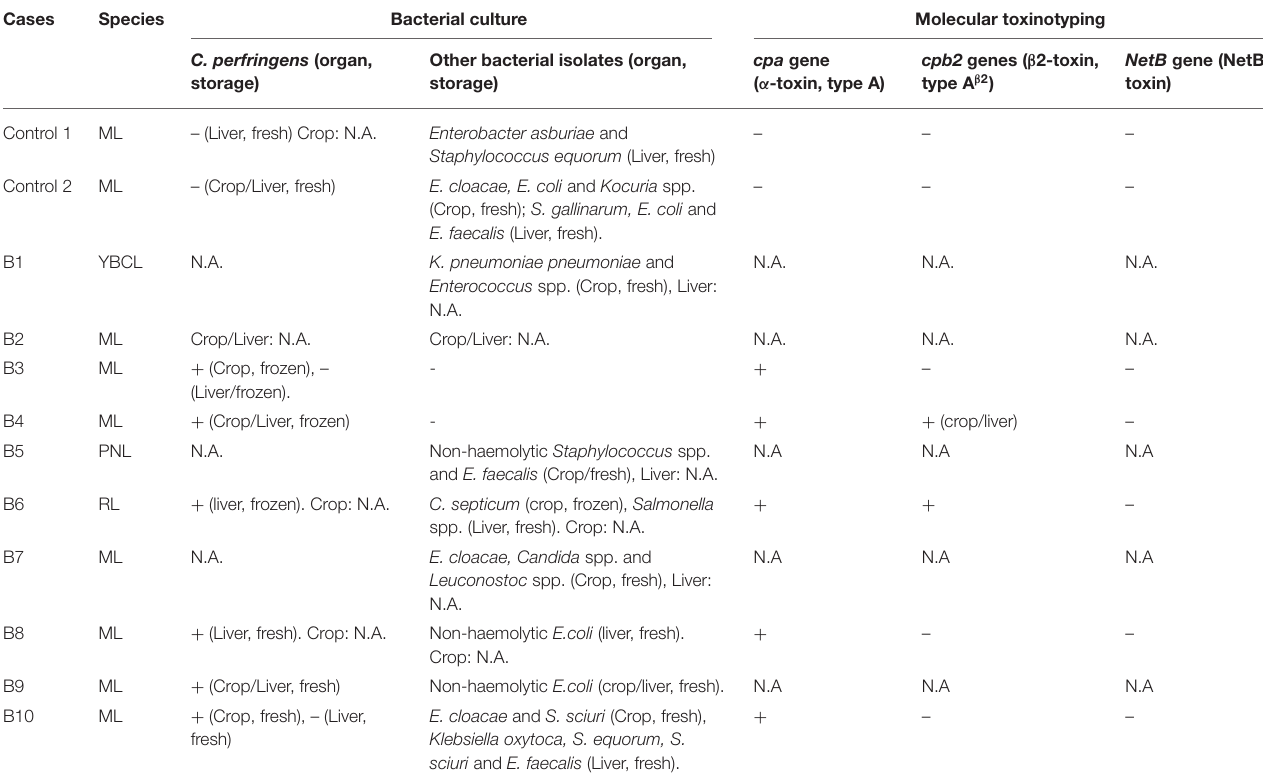
TABLE 2 | Bacterial culture and C. perfringens molecular toxinotyping results from birds with NBEI.